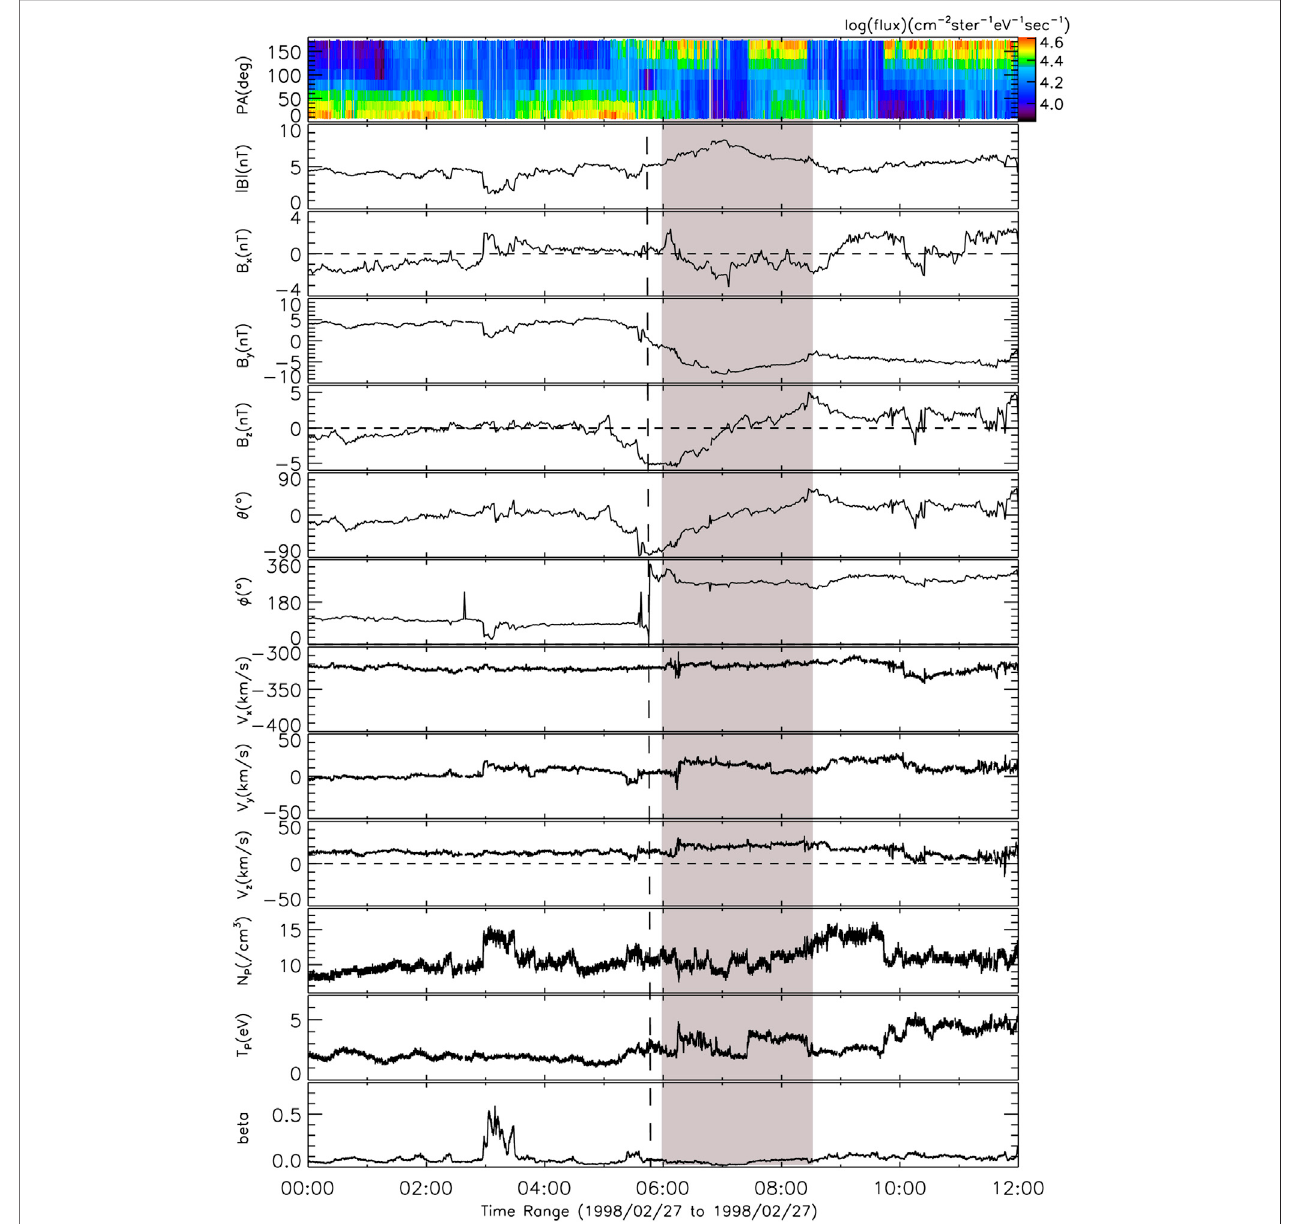
FIGURE2| Anexampleofamagnetic fl uxropedetectedinthevicinityofanHCSonFebruary27,1998.Fromtoptobottom,thepitchangledistributionofelectrons with energy of 228 eV, the magnitude and the three components of the magnetic fi eld, the angular coordinates of the magnetic fi eld vector, the three components of velocity,thenumberdensity,thetemperatureofprotons,andtheplasma β values.TheverticaldashedlineindicatesthecrossingtimeoftheHCSbythespacecraft.The shadow region indicates the magnetic fl ux rope.